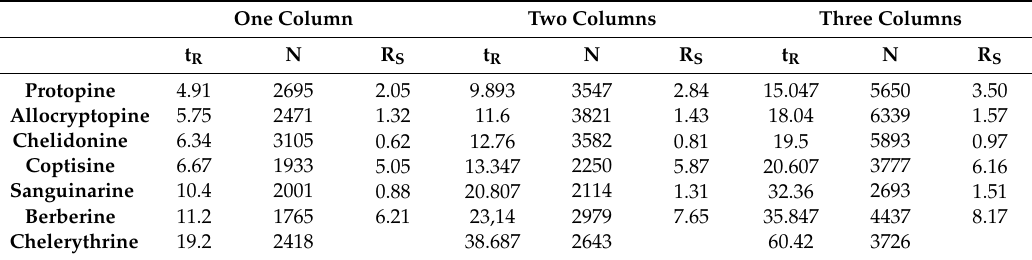
Table 1. Retention times (t R ), theoretical plate number (N), and resolution between neighboring peaks (R s ) obtained for the mobile phase composed of 20% acetonitrile and a 15 mM aqueous solution of ammonium acetate adjusted, using acetic acid, to pH 4 with the use of one and a combination of two and three monolithic columns. One Column Two Columns Three